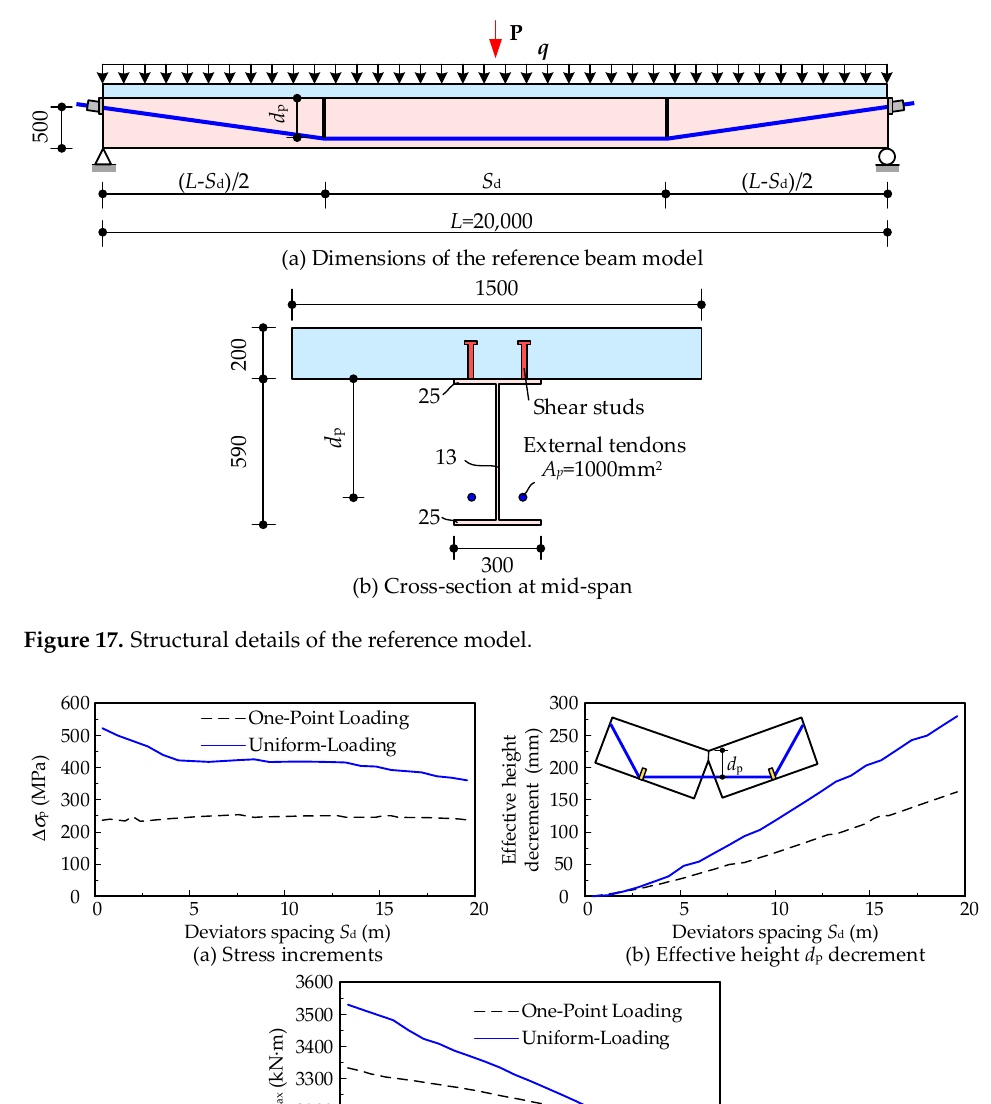
Figure 17. Structural details of the reference model.